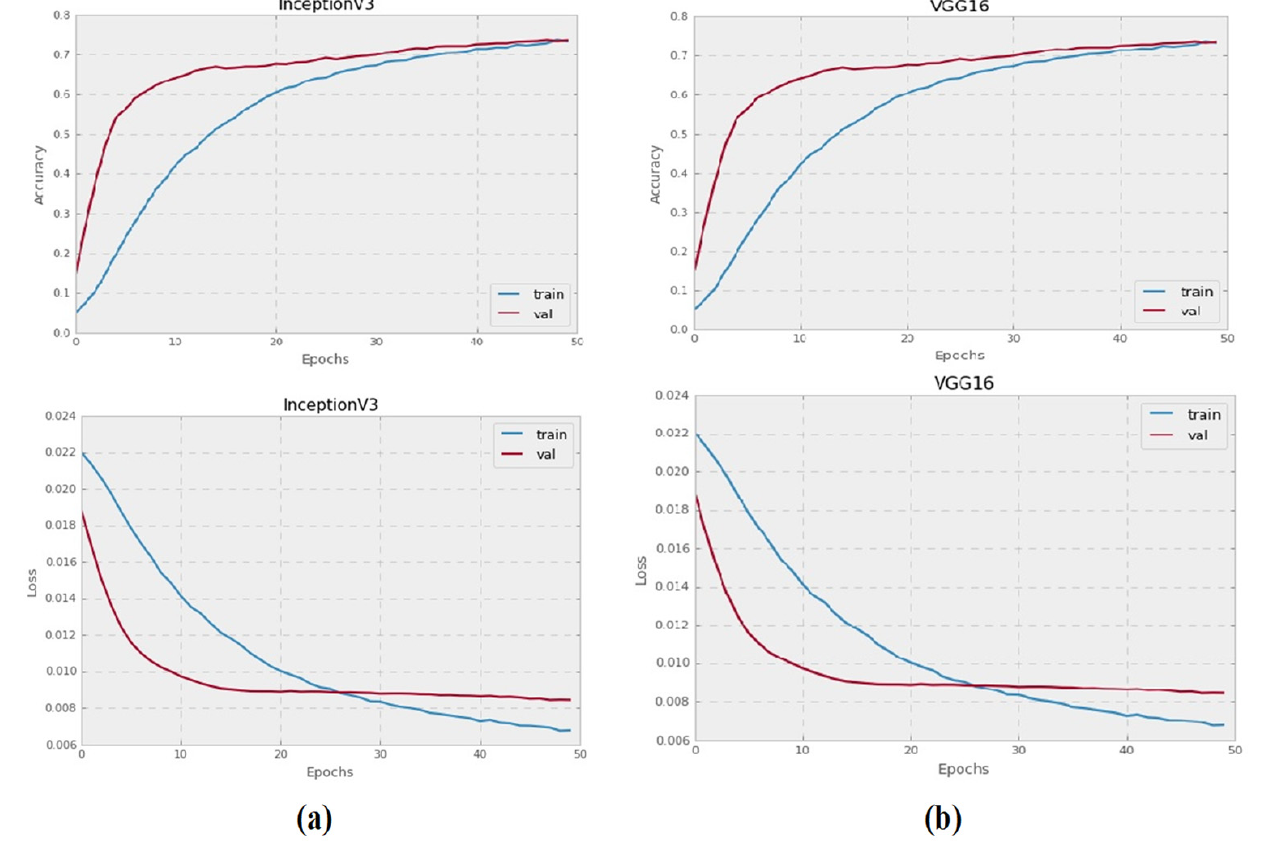
Figure 3. The performance graphs of Inception-V3 and VG16 pre-trained models on grayscale im- ages: ( a ) validation accuracies, and training and validation loss of Inception-V3 model on grayscale images, ( b ) validation accuracies, and training and validation loss of VGG16 on grayscale images. According to the results of the evaluation, Inception-V3 provided better classification accuracy for grayscale images than VGG-16. Figure 4 illustrates the confusion matrices obtained using the Inception-V3 and VGG16 models.